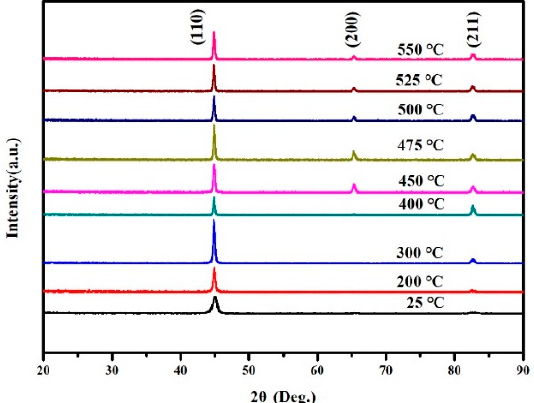
Figure 4. GI-XRDpatternsforFeCothinfilmswiththicknessof800nmdepositedatdifferenttemperatures. Figure 4. GI-XRD patterns for FeCo thin films with thickness of 800 nm deposited at different tem- peratures.